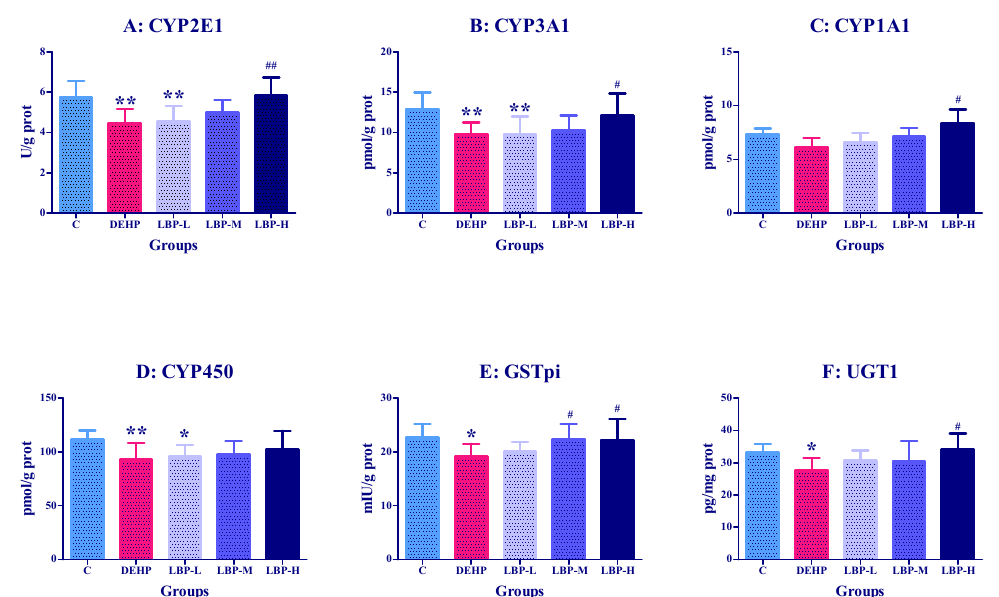
Figure 2. Effects of LBP intervention before DEHP exposure on liver metabolic enzyme activities in rats ( n = 8). Lycium barbarum polysaccharide was continuously given for seven days, and DEHP was fed on the last day. The related liver metabolic enzyme activities (CYP2E1, CYP3A1, CYP1A1, CYP450, GSTpi, and UGT1) were determined by ELISA kit. ( A ), ( B ), ( C ), ( D ), ( E ), and ( F ): Concentrations or activities of CYP2E1, CYP3A1, CYP1A1, CYP450, GSTpi and UGT1 in liver, respectively. Data are expressed by mean ± S.D. The significance of differences among treatment groups was determined by one-way ANOVA. * or **: compared with control group, p < 0.05 or 0.01; # or ## : compared with DEHP group, p < 0.05 or 0.01.